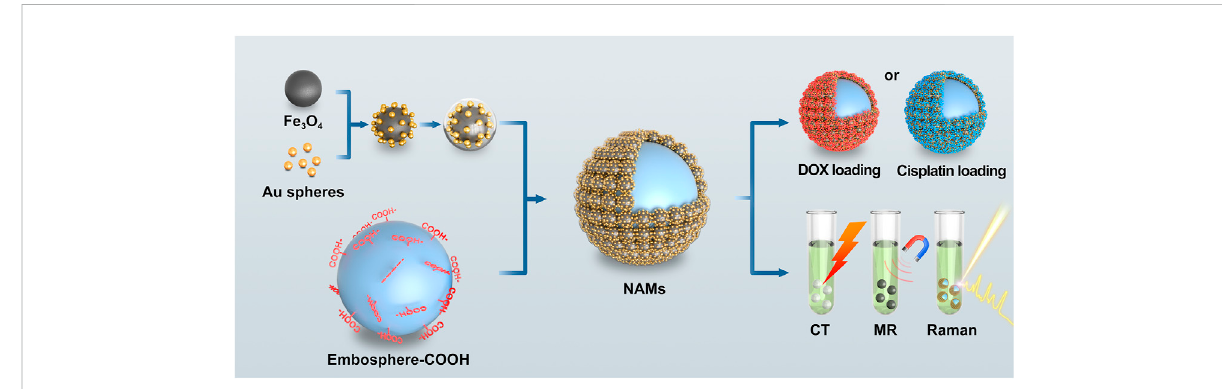
FIGURE 1 Schematic illustration of nano-assembled microspheres for multimodal imaging and drug